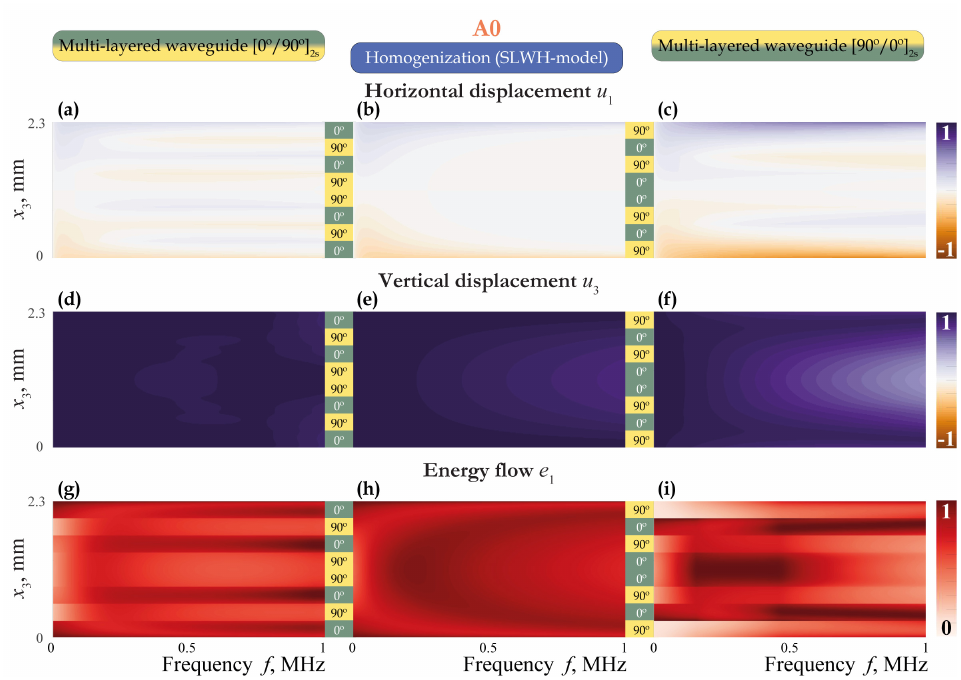
Figure 6. Eigenforms for the first fundamental guided wave A0 propagating in multi-layered waveguide [ 0 ◦ ,90 ◦ ] 2s ( a , d , g ), homogeneous waveguide according to the SLWH-model ( b , e , h ) and multi-layered waveguide [ 90 ◦ ,0 ◦ ] 2s ( c , f , i ).